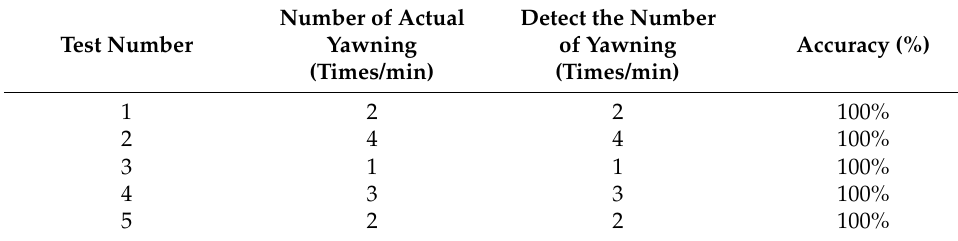
Table 5. Accuracy of mouth fatigue index